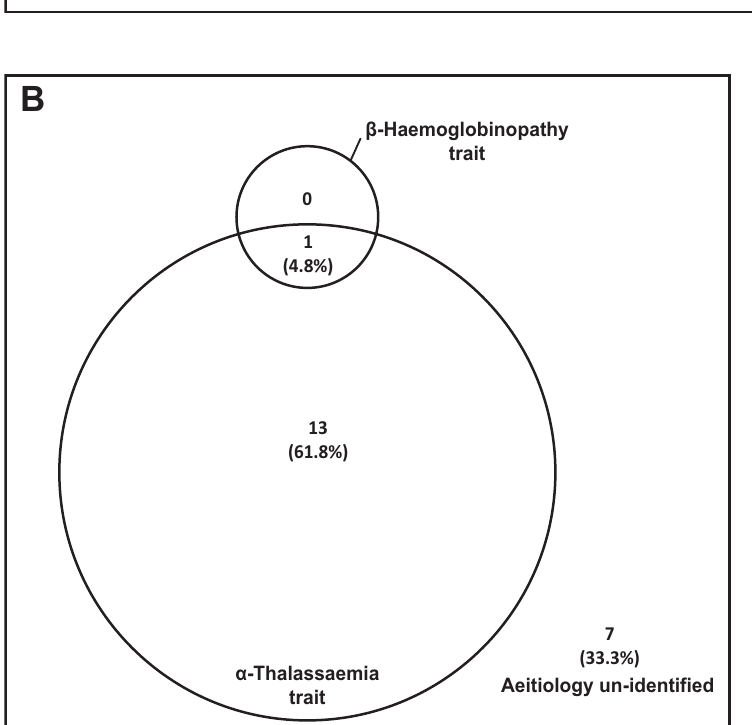
Fig 2. Interactions between iron deficiency and haemoglobinopathies among females with (A) anaemia and (B) low MCV without anaemia . Area of each circle represent the relative contribution of each aetiology for anaemia and low MCV without anaemia.